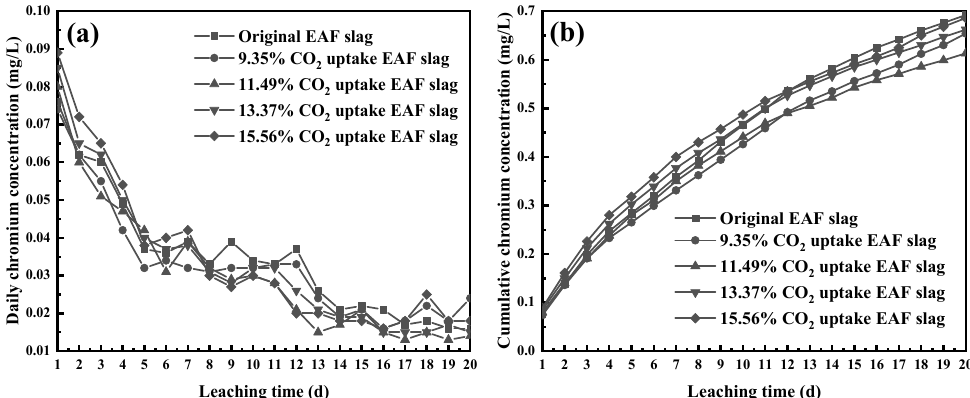
Figure 9. Evolution of daily chromium concentration ( a ) and cumulative chromium concentration ( b ) as a function of leaching time.